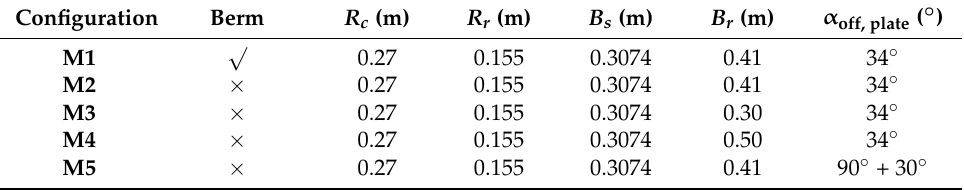
Figure 7. ( a ) The original d w,high configuration (M1); ( b ) the configuration without a berm (M2); ( c ) B r = 0.3 m (M3); ( d ) B r = 0.5 m (M4); and ( e ) the sloping plate 90 ◦ + 30 ◦ (M5). Table 3. The geometrical characteristics of the configurations analyzed (Figure